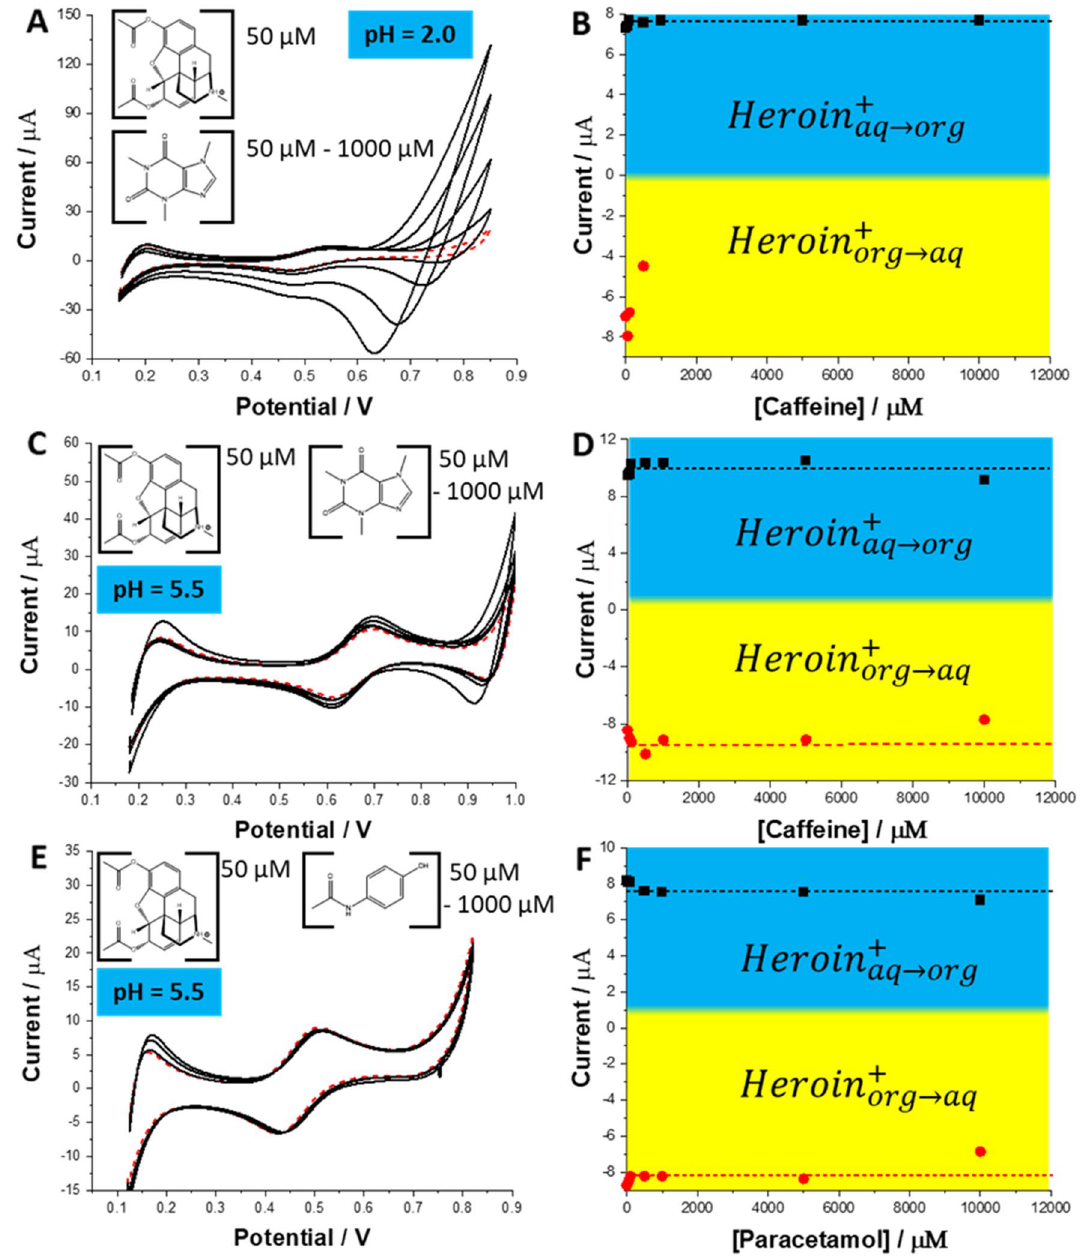
Figure 2. CVs recorded in the presence of [heroin] = 50 µM in the aqueous phase (dashed, red line) and ( A ) – [caffeine] = 50; 100; 500; 1000; 5000 and 10,000 µM at pH = 2.0; ( B ) – [caffeine] = 50; 100; 500; 1000; 5000 and 10,000 µM at pH = 5.5; and ( C ) – [paracetamol] = 50; 100; 500; 1000; 5000 and 10,000 µM at pH = 5.5. Scan rate was 20 mV s −1 . Graphs ( B ), ( D ) and ( F ) correspond to the positive and negative ionic current originating from the heroin cation ion transfer (correlation between signal sign and direction of ion transfer is indicted on the figure) plotted in function of the cutting agent concentration, prepared based on CVs from section ( A ), ( C ) and ( E ),